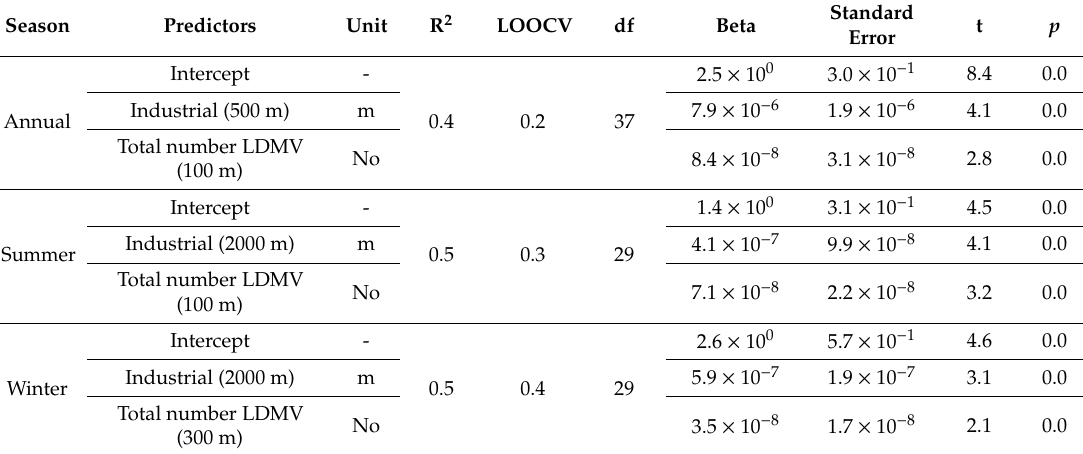
Table 3. Annual, summer, and winter SO 2 LUR model